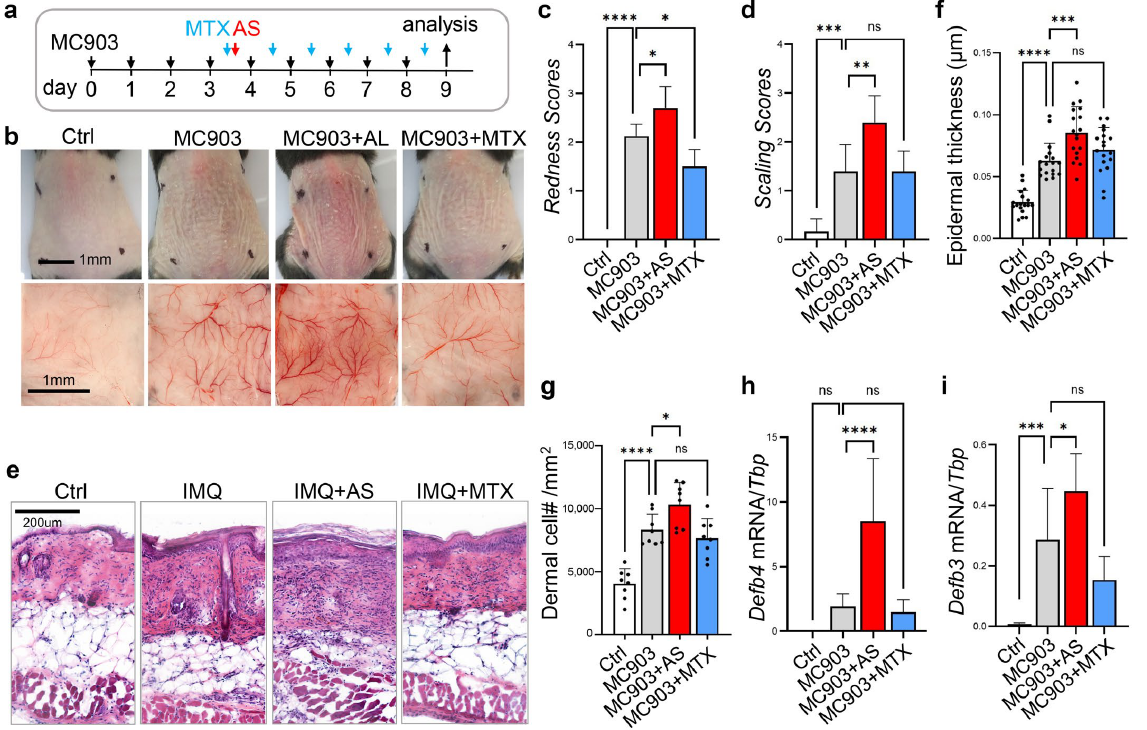
Figure 4. Administration of aluminum salt promoted the development of MC903-induced atopic dermatitis-like skin inflammation: ( a ) Overview of the experimental setting. Atopic dermatitis-like skin inflammation was triggered by daily topical application of MC903 to mouse dorsal skin for 9 days with or without AS injection between day 3~4 or daily MTX injection from day 3~4 as indicated; ( b ) Representative skin images for each group at day 9; ( c ) Bar graphs showing quantified redness scores for each group ( n = 5 mice/group); ( d ) Bar graphs showing quantified scaling scores for each group; ( e ) HE staining of skin sections from each group ( n = 5 mice /group); ( f ) Bar graphs showing quantified epidermal thickness for each group ( n = 15~20 fields/group); ( g ) Bar graphs showing quantified dermal cell density for each group ( n = 8 fields/group); ( h , i ) qRT-PCR analysis of the mRNA expression levels of Defb4 and Defb3 (ratios to housekeeping gene Tbp were shown, n = 6~8/group) . All error bars indicate mean ± SEM, and statistical analysis was performed by one way ANOVA analysis with Dunnett -corrected multiple comparisons. * p < 0.05, ** p < 0.01, *** p < 0.001, **** p < 0.0001, ns, non-significant.